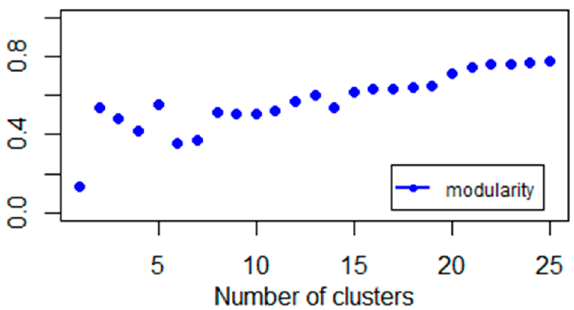
Figure 8. Explained percentage variance of Gaussian-kernel based clusters.